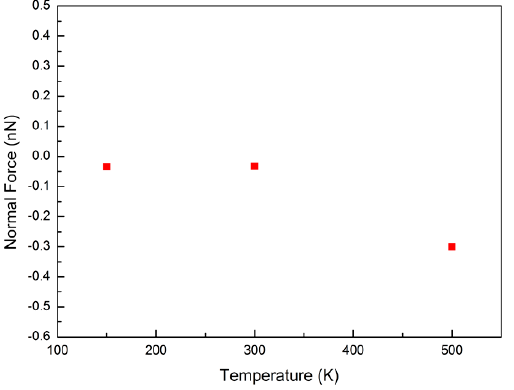
Figure 7. Variation of normal force between shells with time for temperatures of 150, 300, and 500 K.